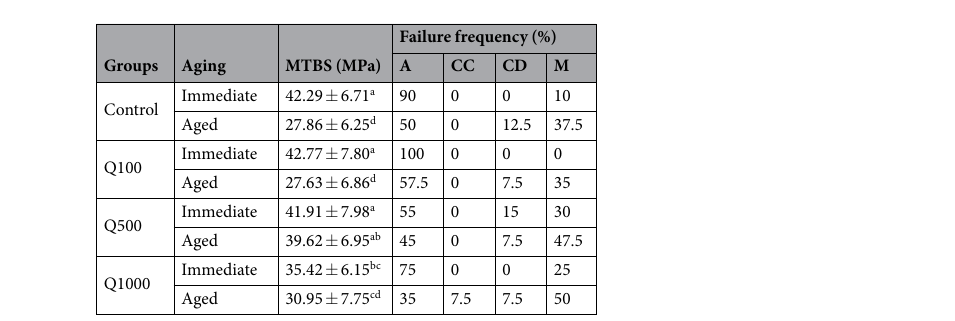
Table 1. Microtensile bond strength (MTBS) and failure frequency of each group. The MTBS values are expressed as mean ± SD in MPa, n = 40. Groups with the same letters are not statistically different ( P > 0.05). A, adhesive failure; CC, cohesive failure in composite; CD, cohesive failure in dentin; M, mixed